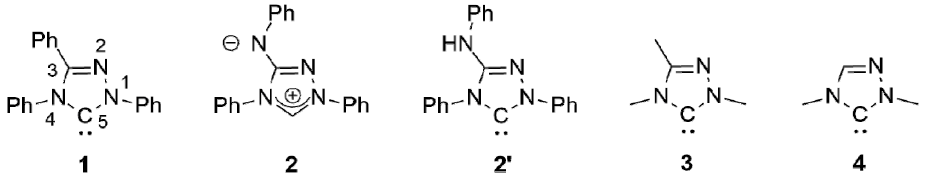
Figure 1. The “Enders carbene” ( 1 ), Nitron ( 2 ) and its carbenic tautomer ( 2 ′ ), the methyl homologue ( 3 ) of 1 and 1,4-dimethyl-1,2,4-triazol-5-ylidene ( 4 ).